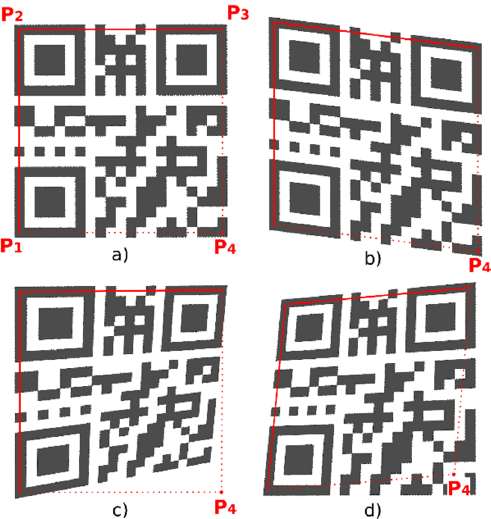
Figure 11. Initial estimate of position of 4th point P 4 . ( a ) undistorted QR Code; ( b ) skewed QR Code; ( c ) and ( d ) perspective distorted QR Codes.